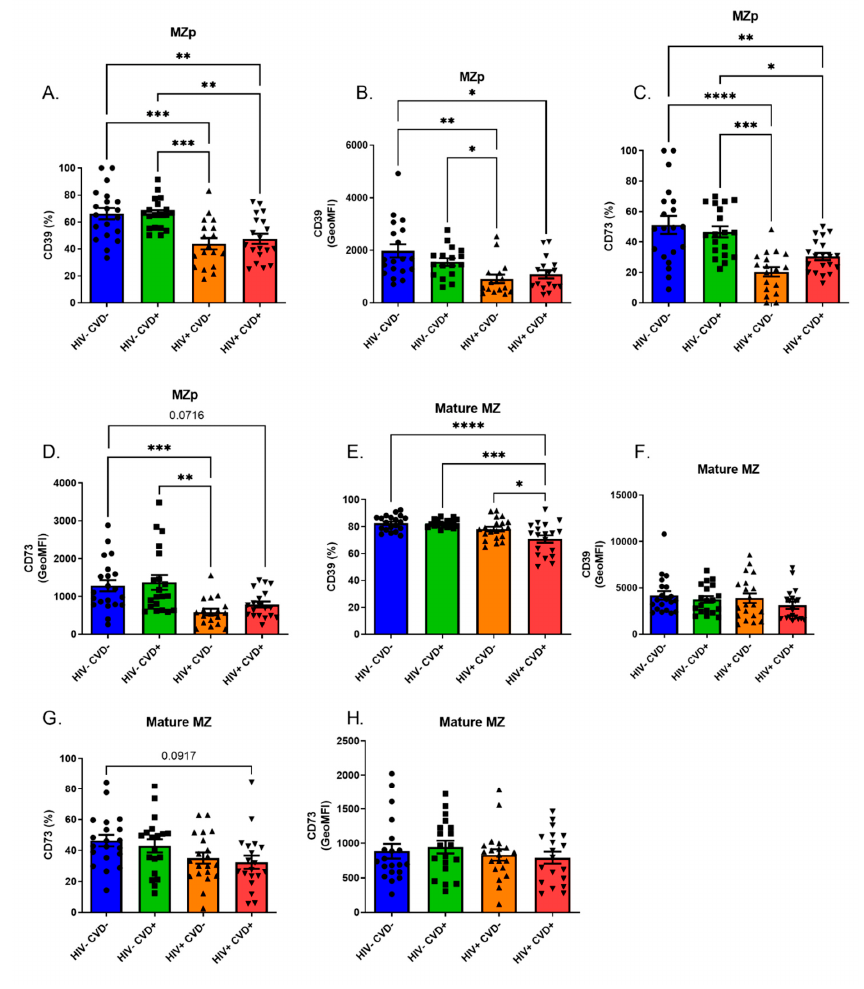
Figure 4. Immunoregulatory markers of the adenosine pathway, CD39 and CD73, are downregulated on blood marginal zone precursor-like (MZp) B-cells of HIV-infected (HIV+) individuals from